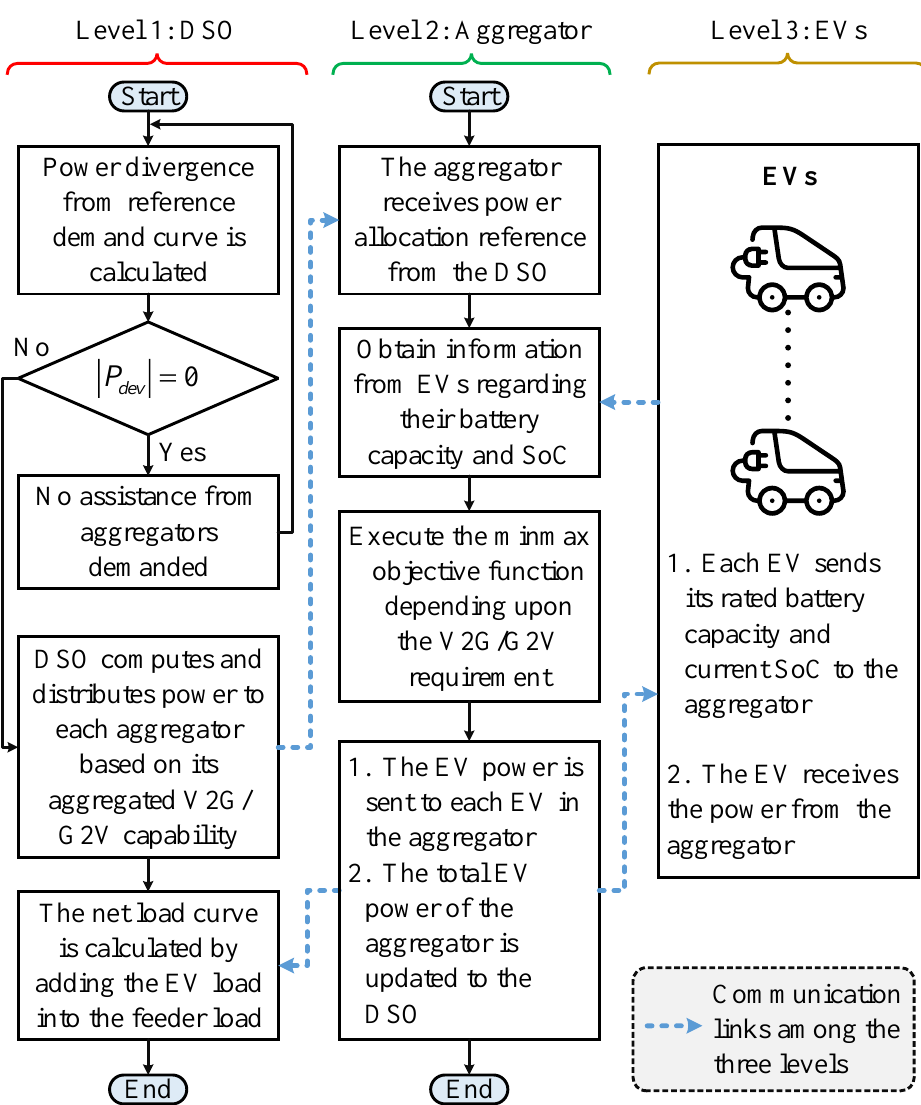
Figure 2. The comprehensive control flow chart of the proposed strategy at the three levels: distribu- tion system operator (DSO), aggregator and electric vehicles